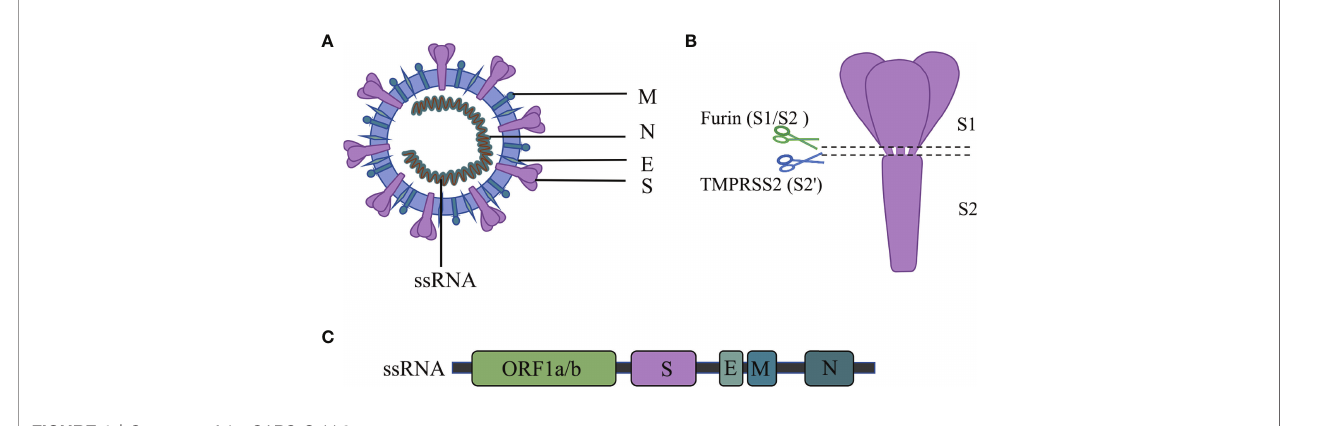
FIGURE 1 | Structure of the SARS-CoV-2.